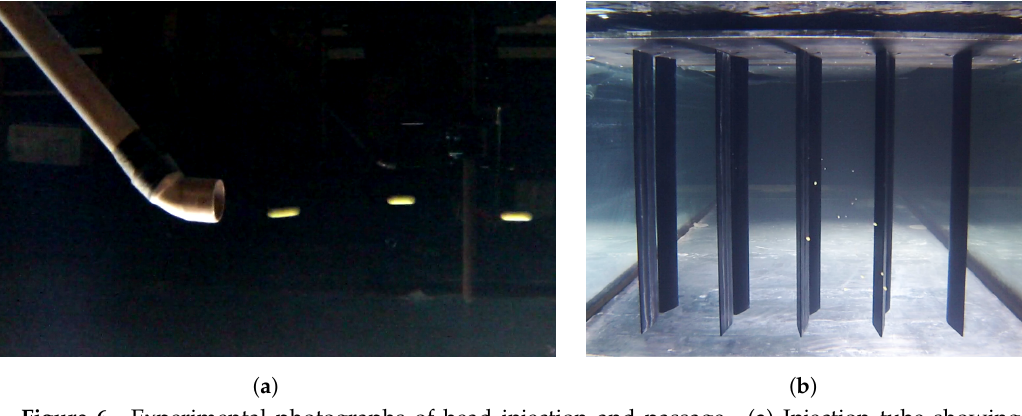
Figure 6. Experimental photographs of bead injection and passage. ( a ) Injection tube showing the release of rod-shaped beads into flume; ( b ) Bead passage through vane array, viewed from the downstream end of the flume (in - x